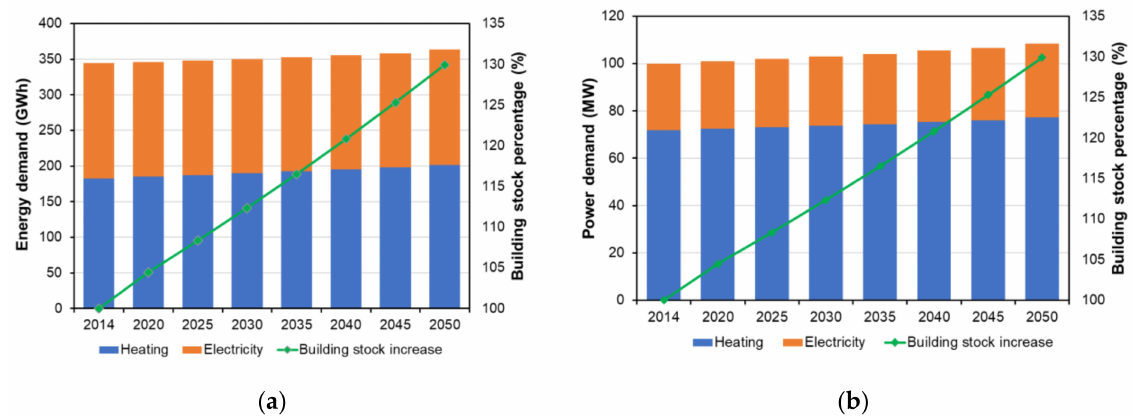
Figure 6. ( a ) Total energy demand of the increased building stock with normal development rate; ( b ) total power capacity demand of the increased building stock with normal development rate.